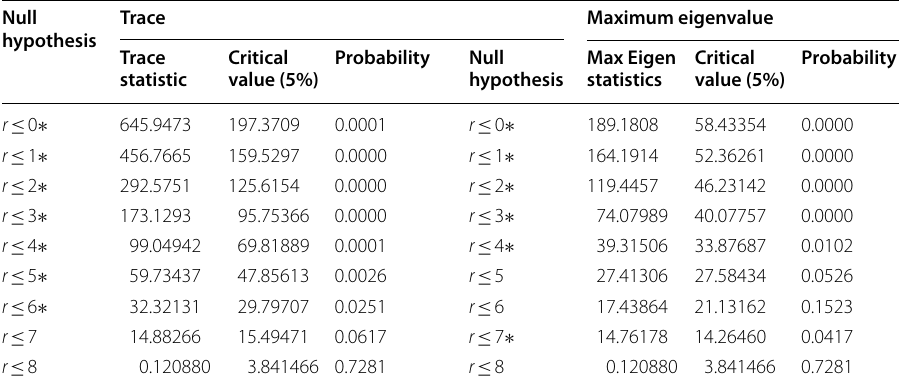
*Trace statistics indicate 7, and maximum eigenvalues indicate 5 cointegrating equation(s) at the 0.05 level. *Denotes rejection of the hypothesis at the 0.05